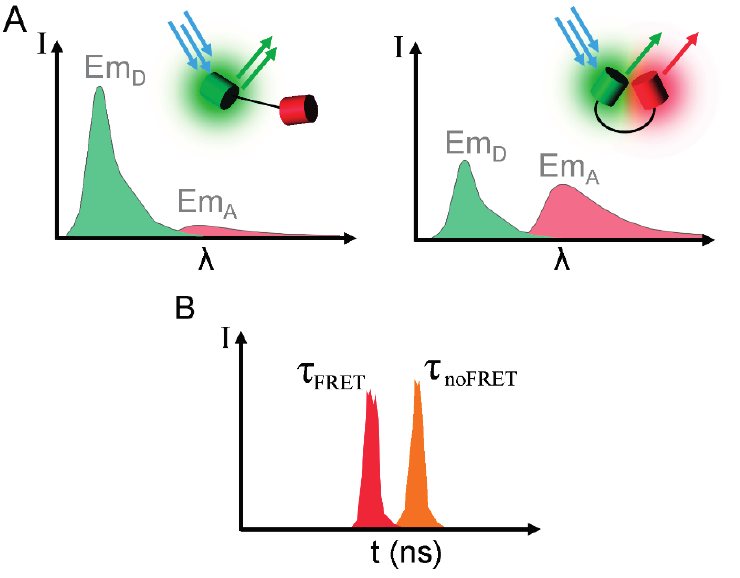
Figure 3. Effects of FRET on the spectroscopic properties. ( A ) FRET produces a change in the emissions intensities of the donor (Em D ) and the acceptor (Em A ), clearly measurable as a change in ratio; ( B ) FRET has a characteristic effect on the fluorescent lifetime τ , the delay between excitation and